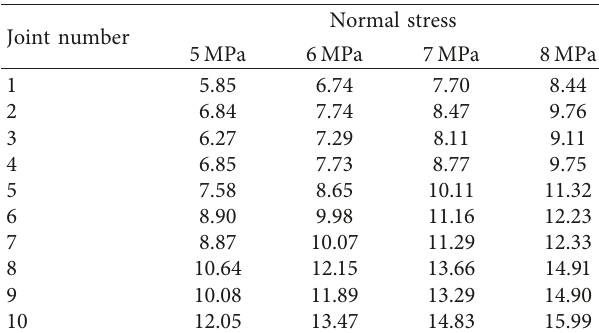
Figure 12: The scheme of numerical direct shear test. Table 5: τ LR values of joint simulated by the